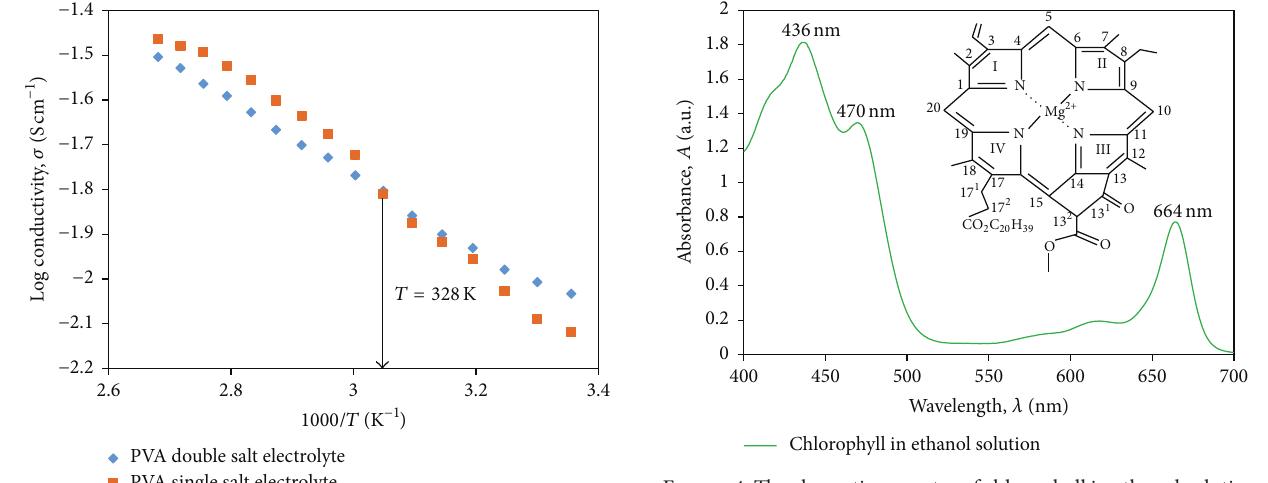
Figure 4: The absorption spectra of chlorophyll in ethanol solution. Mass of TiO 2 electrode before soaking in chlorophyll solution Mass of TiO 2 electrode after soaking in chlorophyll and drying Mass of chlorophyll adhered 0.0006